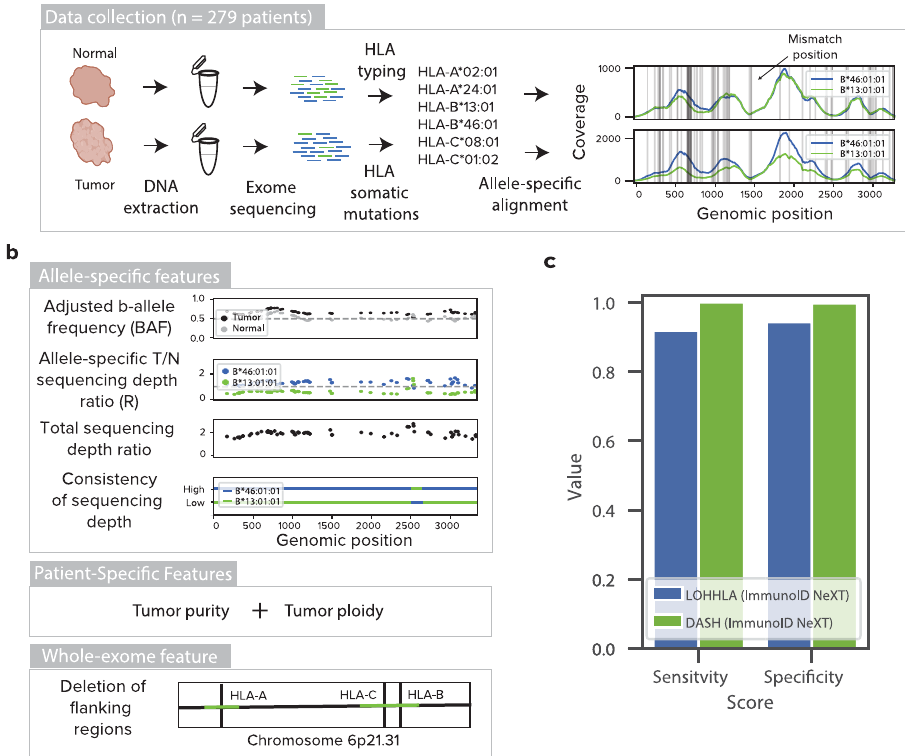
Fig. 1 Training, performance, and limit of detection of DASH algorithm. a Tumor and adjacent normal samples were collected for 279 patients. DNA was extracted and exome sequencing was performed. HLA typing was derived from the normal sample and HLA somatic mutations were obtained from the tumor sample. Reads mapping to an HLA reference database were assembled and mapped onto the patient-speci fi c HLA alleles. Horizontal gray lines denote positions where the homologous alleles differ from each other. b Features used to train the DASH algorithm include the adjusted b-allele frequency, sequencing depth ratio, total sequencing depth ratio, consistency of sequencing depth, tumor purity, tumor ploidy and deletion of fl anking regions. Dashed gray lines represent the expected values for a sample without copy number change. All features were used to train an XGBoost prediction model. c A bar plot showing the sensitivity and speci fi city of HLA LOH detection by DASH and LOHHLA for samples in the 10-fold cross validation data set. Both algorithms were tested on the HLA-enhanced ImmunoID NeXT Platform. Only samples with at least 20% tumor purity were included. Source data are provided with this